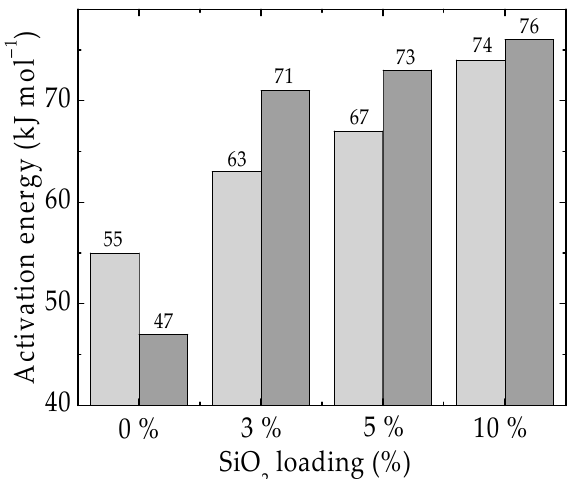
Figure 7. Histogram of the activation energies calculated for the oxidation of PLA/SIS/30 loaded with silica as nonirradiated samples (light grey) or the materials receiving 25 kGy (dark grey).